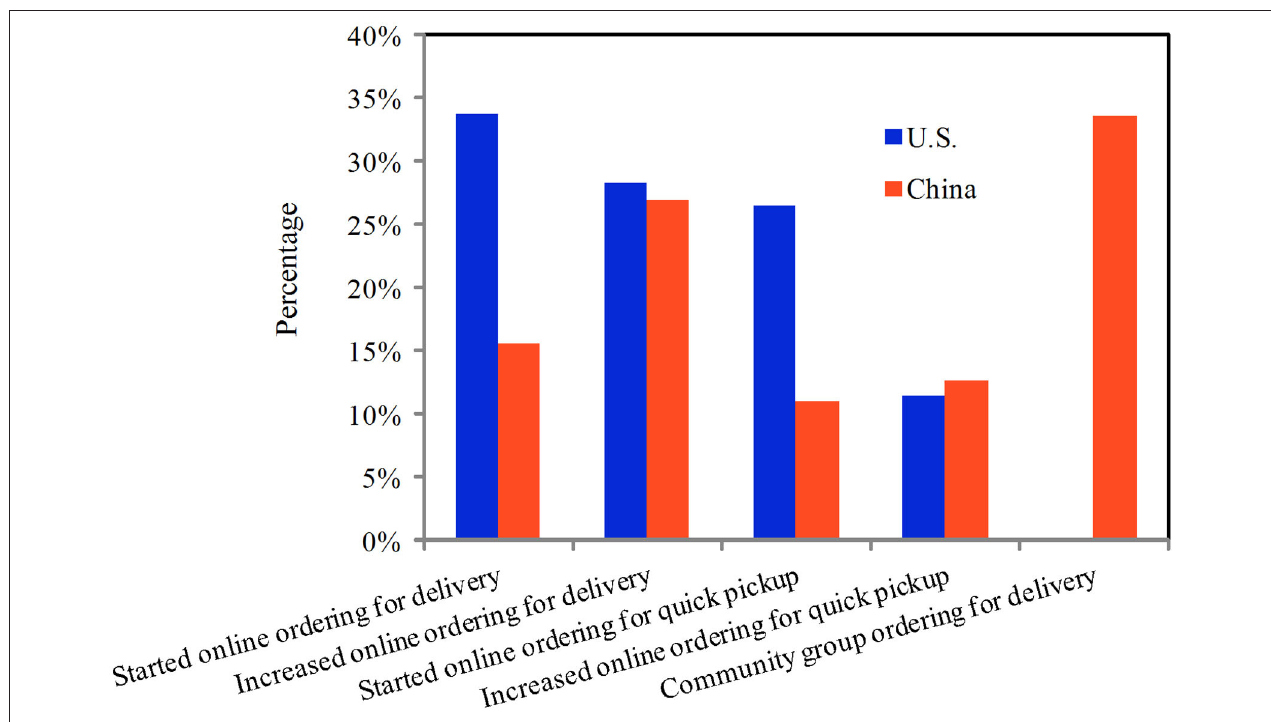
FIGURE 2 | Online grocery-shopping increased dramatically during the COVID-19 pandemic. Many reported ordering groceries online for delivery or curbside pickup for the first time. About 1/3 of the Chinese cohort reported community-based group ordering for